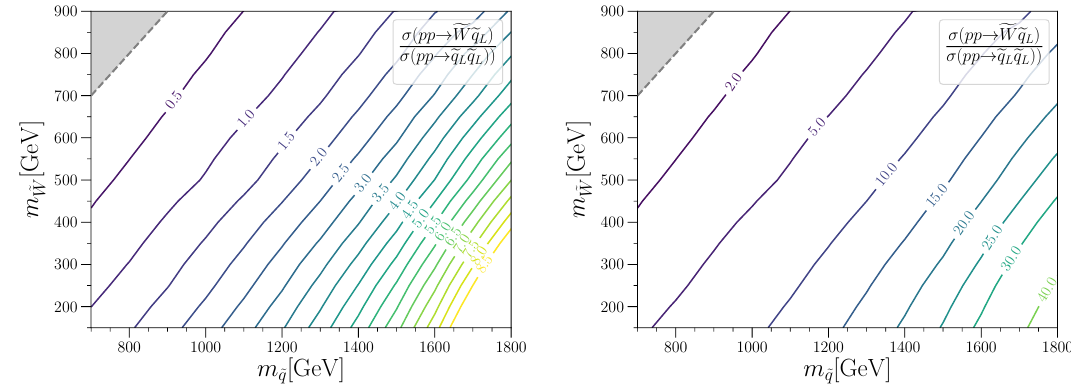
Figure 3 . The cross section ratio between pp plots correspond to the 8- and 2-flavour scenarios, respectively.